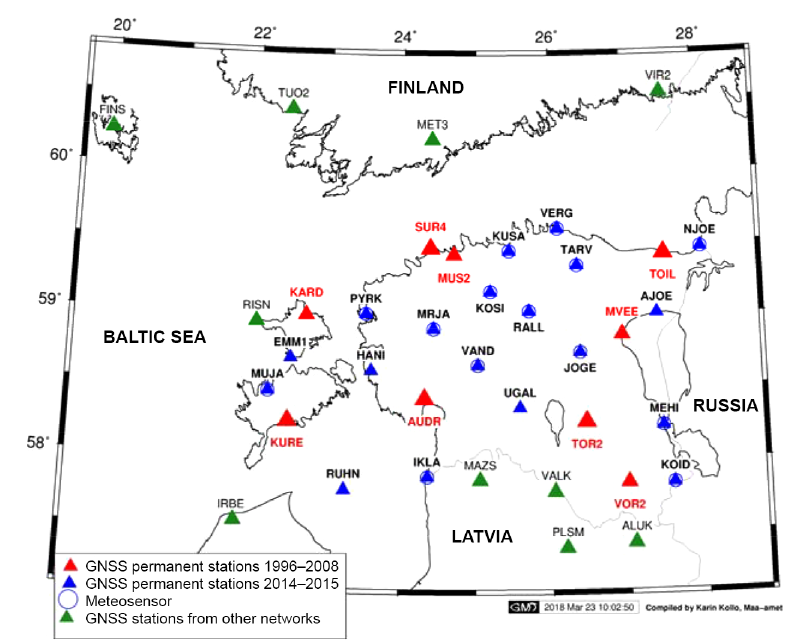
Figure 5. Typical installation of most ESTPOS stations – an AR25 Choke Ring radome antenna with the Vaisala WXT520 meteo sensor and an equipment housing containing a GR25 receiver and a converter for the meteo